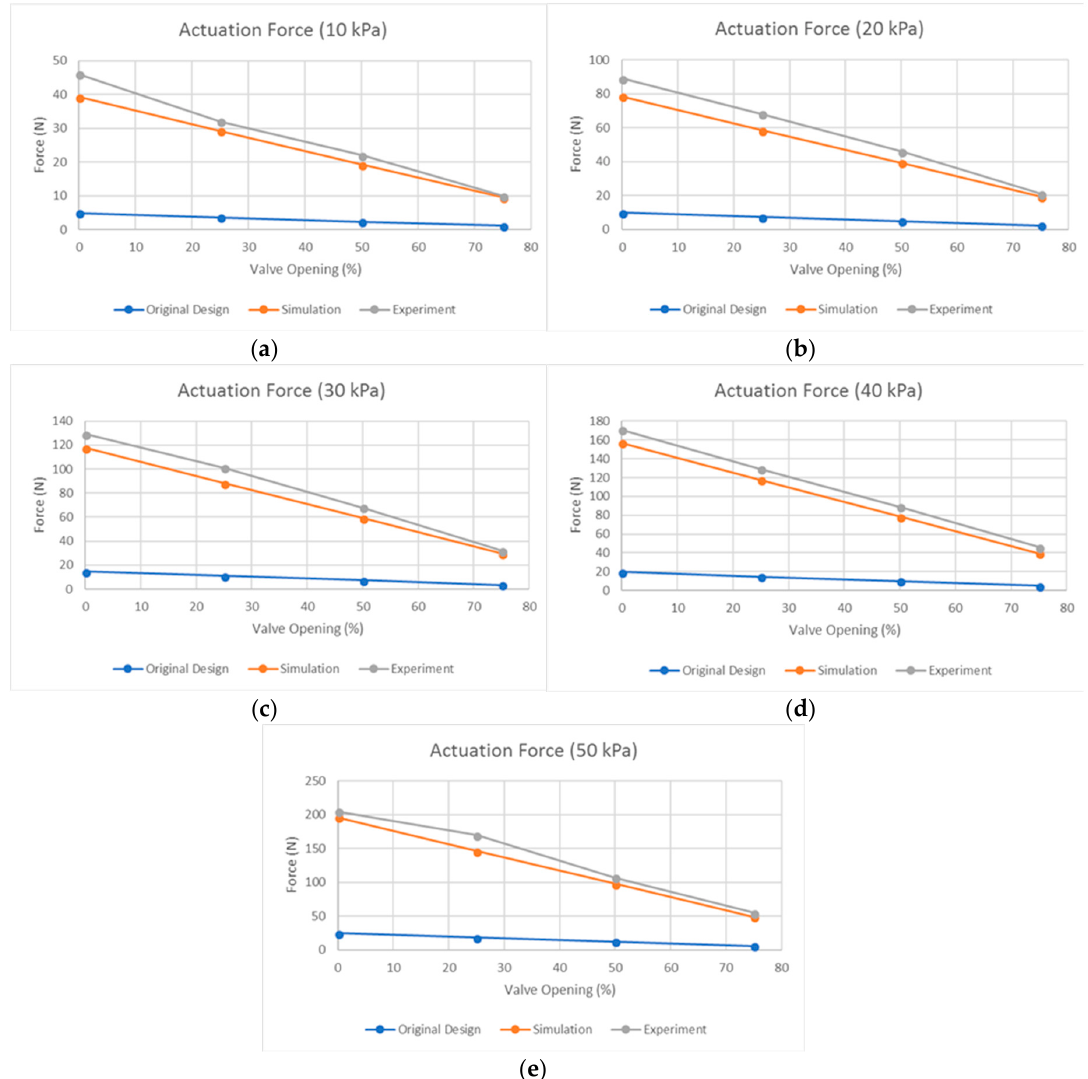
Figure 9. Valve actuation force comparison at: ( a ) 10 kPa; ( b ) 20 kPa; ( c ) 30 kPa; ( d ) 40 kPa; ( e ) 50 kPa.